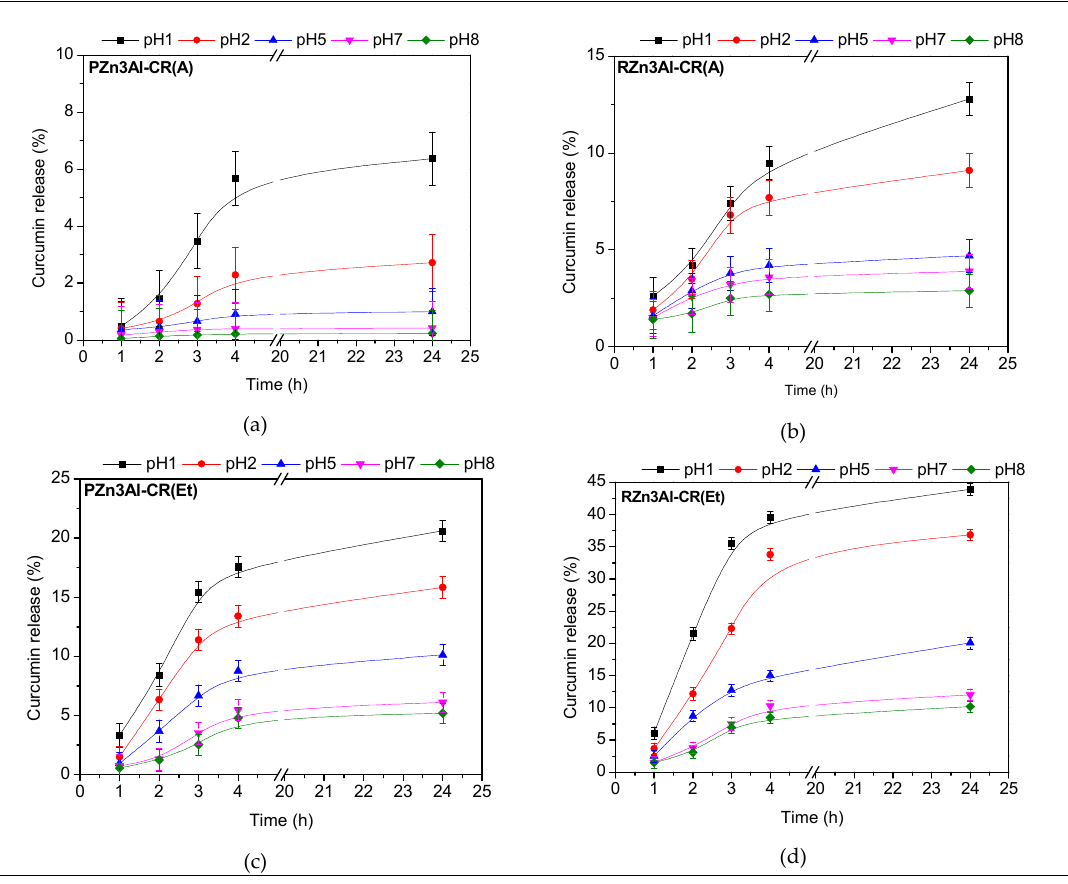
Figure 8. Curcumin release from the solid samples during 24 h in different pH buffers: ( a ) PZn3Al-CR(Aq); ( b ) RZn3Al-CR(Aq); ( c ) PZn3Al-CR(Et); ( d ) RZn3Al-CR(Et).